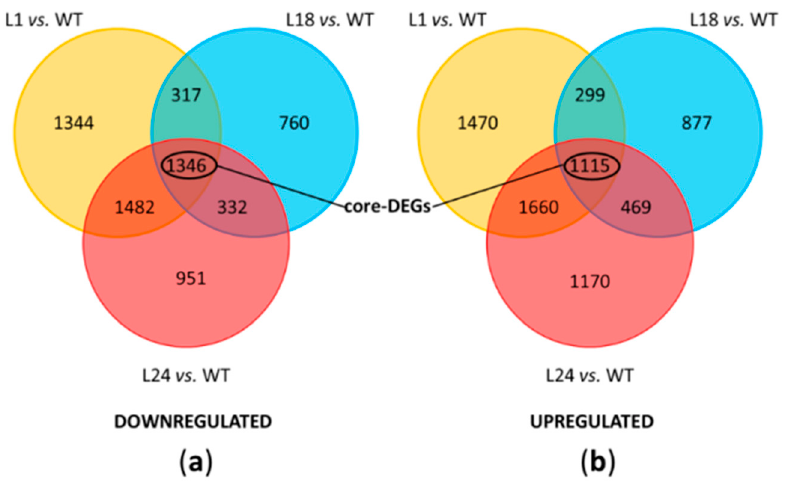
Figure 3. Differentially expressed genes (DEGs) between AtMYB4oe lines and WT: Venn diagrams of the number of ( a ) downregulated and ( b ) upregulated genes for all comparisons (FDR < 0.05). Validation of the RNA-seq expression data was performed by means of RT-qPCR, testing the expression of selected core-DEGs. In particular, in order to span a consistent range of FC values ( − 7.99 < log 2 FC < +8.14) and gene functions, the following were tested: genes encoding phenylpropanoid enzymes ( Ccrd_010165 /C4H, Ccrd_015556 /4CL, Ccrd_015561 /HCT, Ccrd_004659 /CCoAOMT), other enzymes ( Ccrd_024577 /NADPH